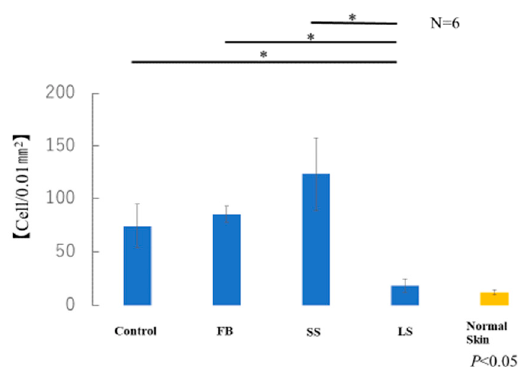
Figure 11. Number of α -smooth muscle actin ( α -SMA)-positive myofibroblasts (* p < 0.05).